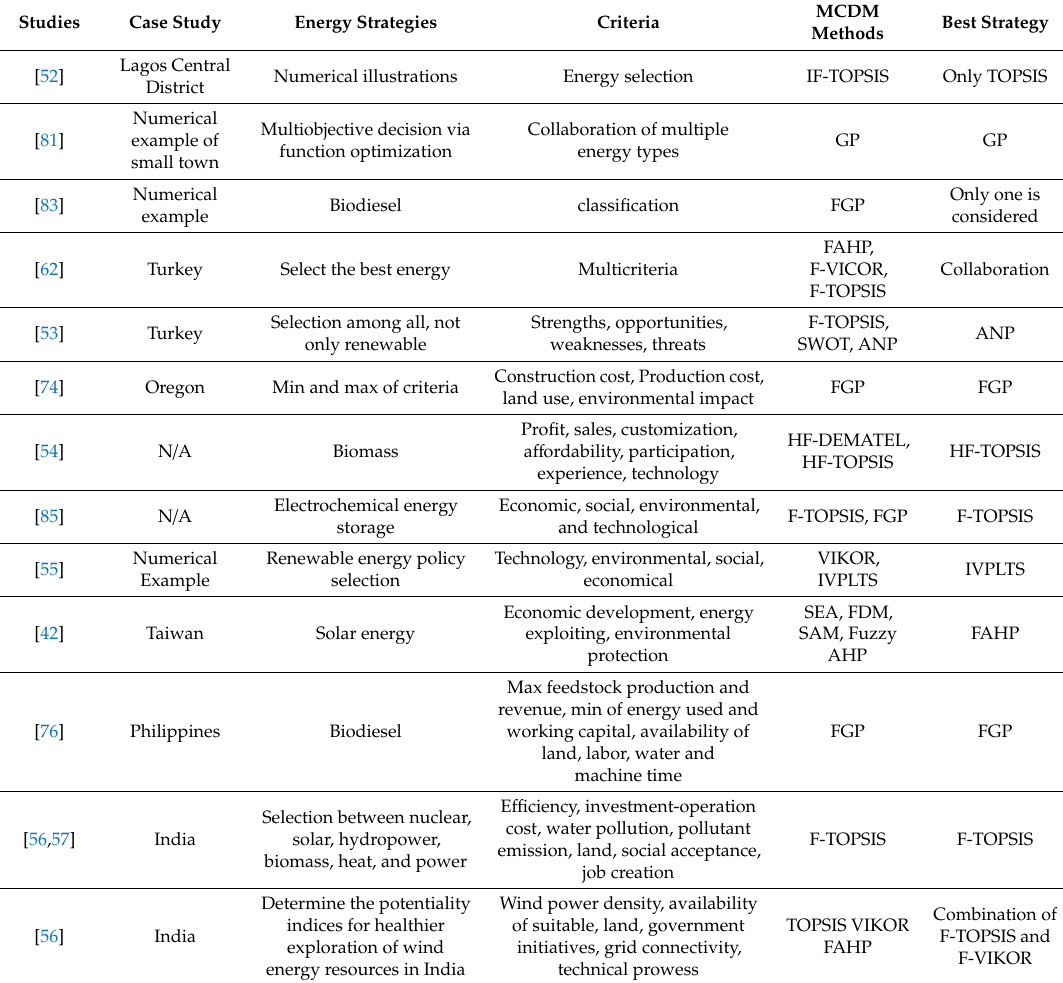
Table 3. Comparison of research results related to renewable energy selection using stochastic fuzzy analytic hierarchical process (SF-AHP), fuzzy goal programming (FGP), and fuzzy technique for order performance by similarity to ideal solution